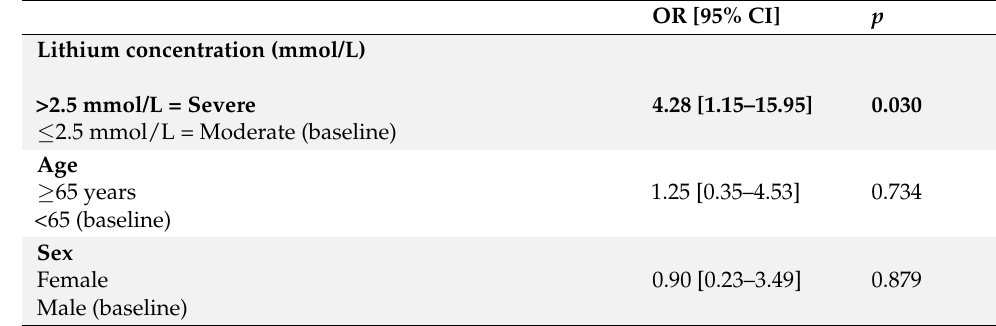
Table 6. Factors associated with QT prolongation at